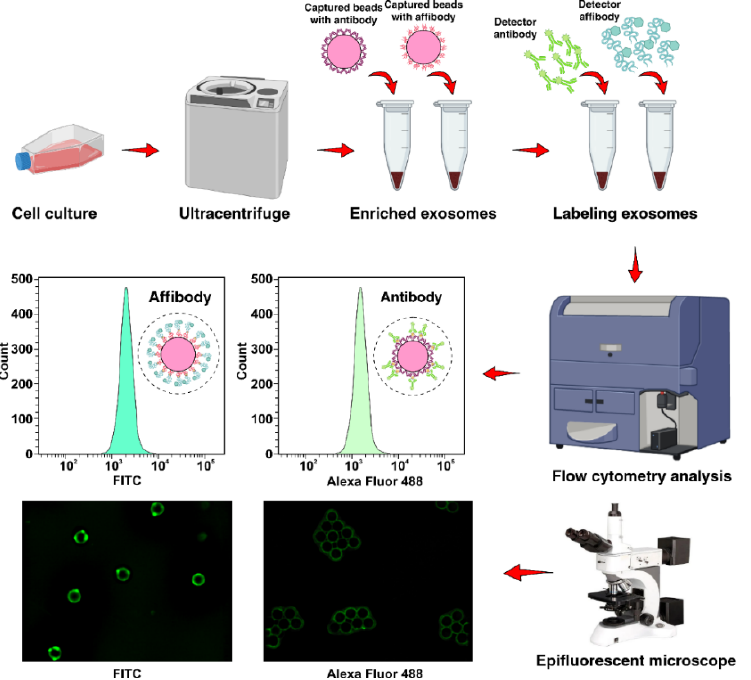
Figure 1. The workflow of detecting pre-enriched EGFR-positive exosomes from A549 cell line with novel Affibody probe using flow cytometry and fluorescent microscopy. The 10 µ m carboxylate polystyrene microbeads functionalized with EDC were incubated with 1.5 µ g of capture anti-EGFR Affibody and anti-EGFR antibody separately. Following the addition of pre-enriched exosomes and incubation for 18 h at 4 ◦ C, the detector anti-EGFR-FITC Affibody and anti-EGFR-Alexa Fluor 488 antibody was added to the AffiBeads/antibody-coated beads and exosome mixture. Afterward, they were subjected to conventional flow cytometry and fluorescence